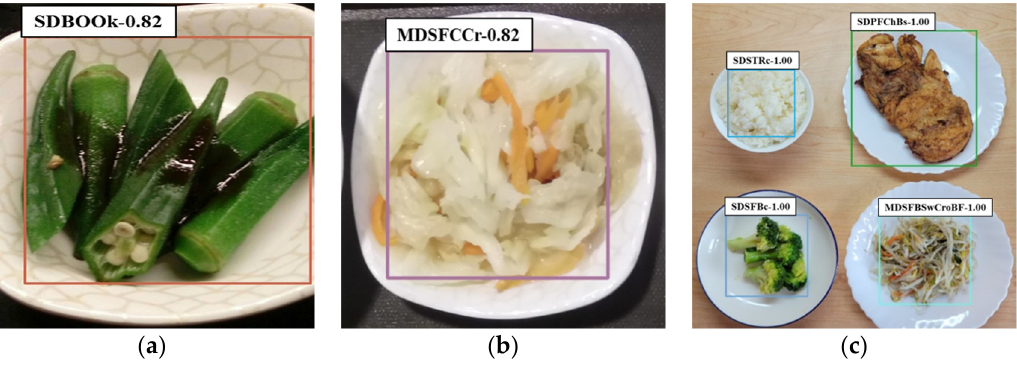
Figure 8. Recognition results of the three dish types: ( a ) single-dish; ( b ) mixed-dish; ( c ) multiple-dish.